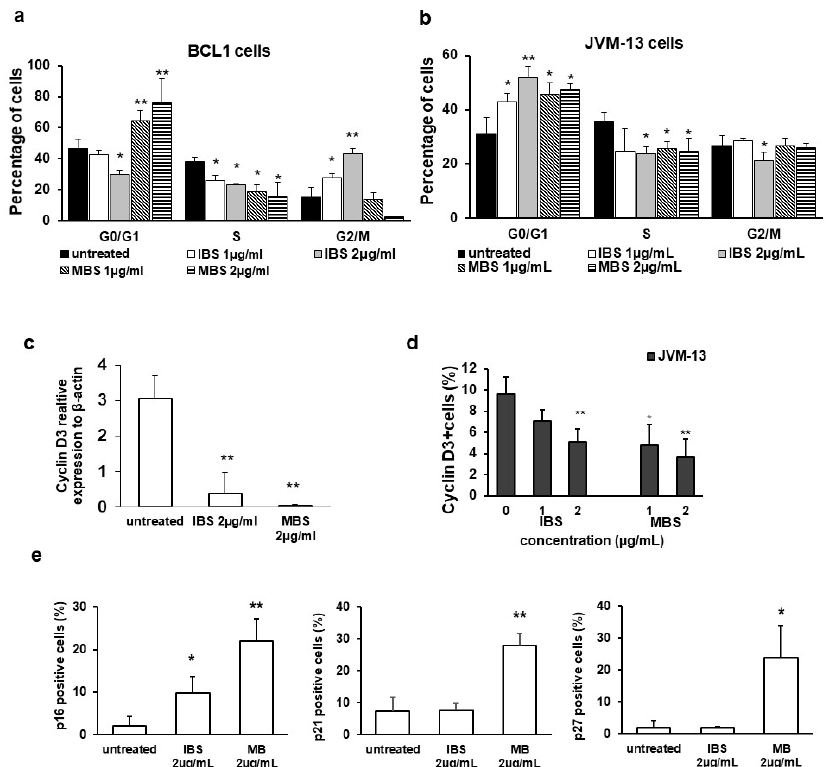
Figure 4. IBS and MBS induce cell cycle disturbances in JVM-13 and BCL1 cells. Distribution of ( a ) BCL1 and ( b ) JVM-13 cells in different phases of the cell cycle after treatment with IBS and MBS (concentrations = 1 µ g/mL and 2 µ g/mL) was determined by flow cytometry after staining with Vybrant ® DyeCycle™ Ruby stain. Results are expressed as the percentage of cells in different phases of the cell cycle. ( c ) mRNA expression of cyclin D3 quantified by RT-PCR in BCL1 cells after treatment with IBS and MBS (2 μ g/mL) for 24 h. ( d ) Percentage of JVM-13 cells expressing cyclin D3 after treatment with two different concentrations of IBS and MBS (1 μ g/mL and 2 μ g/mL) for 24 h determined by flow cytometry. ( e ) Percentage of p16-, p21-, and p27-positive BCL1 cells analyzed by flow cytometry after 24 h treatment with IBS and MBS. Data are presented as the mean ± SD. * p < 0.05, ** p < 0.01 indicates a significant difference from untreated cells. Since it has been shown that inhibition of STAT3 signaling leads to CLL cell death [15] and that the antitumor effects of shikonins are mediated by STAT3 inhibition [16,17], the expression of pSTAT3 in IBS- and MBS-treated BCL1 and JVM-13 cells was analyzed by flow cytometry. Treatment with IBS and MBS significantly reduced the percentage of pSTAT3-expressing BCL1 and JVM-13 cells compared to untreated cells (Figure 5a). This was accompanied by a significantly lower expression of c-Myc, Nanog, and Oct4 mRNA in BCL1 cells and a lower expression of c-Myc, Nanog, Sox2, and Oct4 mRNA in JVM-13 cells (Figure 5b). To further explore the role of shikonin-induced STAT3 inhibition in tumor cell death, the cytotoxic activity of combination of IBS and MBS with the single agent inhibitor of Jak2 (AG490), a molecule that phosphorylates STAT3, was analyzed by MTT assay. As shown in Figure 5c, AG490 alone does not reduce the viability of BCL1 cells after 24 h of exposure. However, simultaneous treatment with AG490 and IBS or MBS induces a significantly higher reduction in BCL1 cell viability in comparison with the single treatment (Figure 5c).